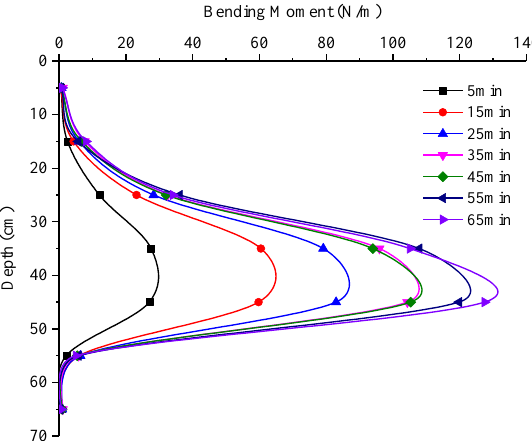
Figure 7. Bending moment diagram for the stabilizing pile.